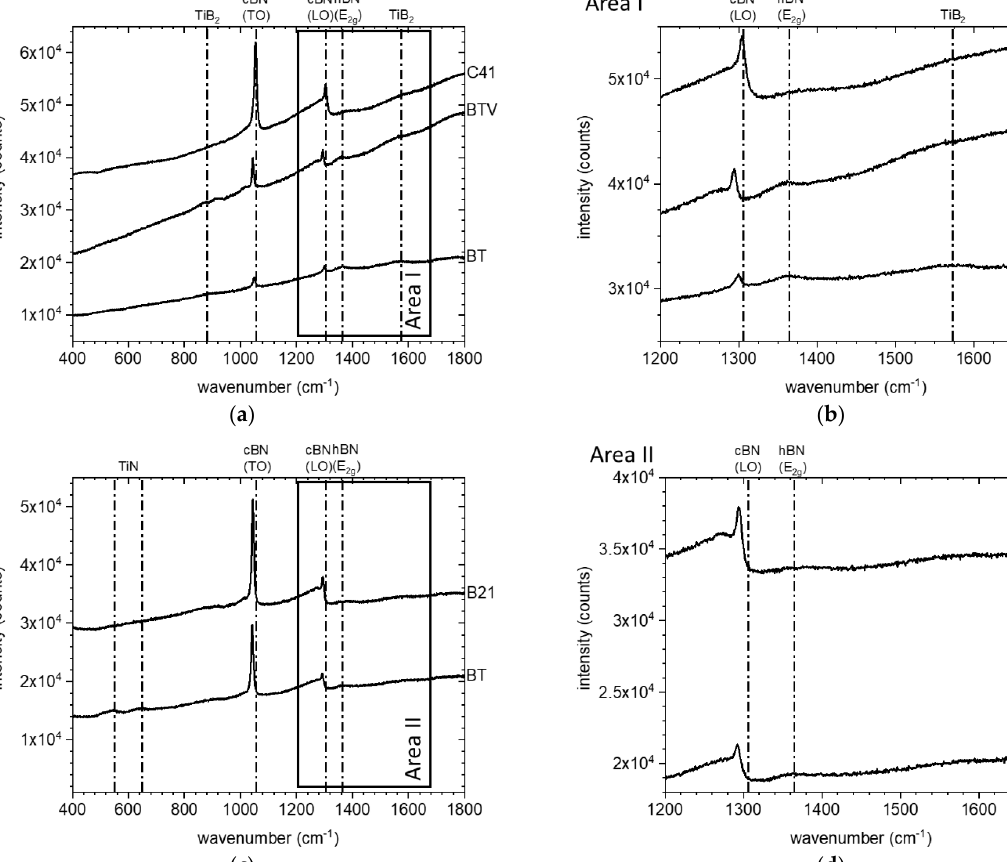
Figure 12. ( a , b ) Raman spectra of the heat-treated powders C41, BT and BTV under Ar atmosphere. ( c , d ) Raman spectra of the heat-treated powders B21 and BT under N2 atmosphere. ( b , d ) are showing a detailed area of the hBN Raman bands in ( a , c ), respectively.